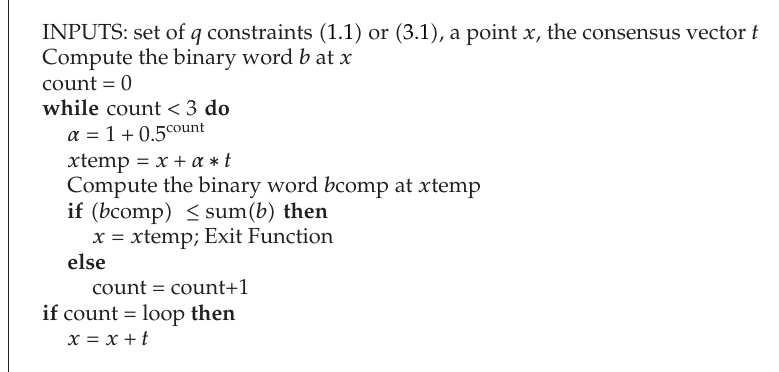
Algorithm 3: Backtracking line search technique.